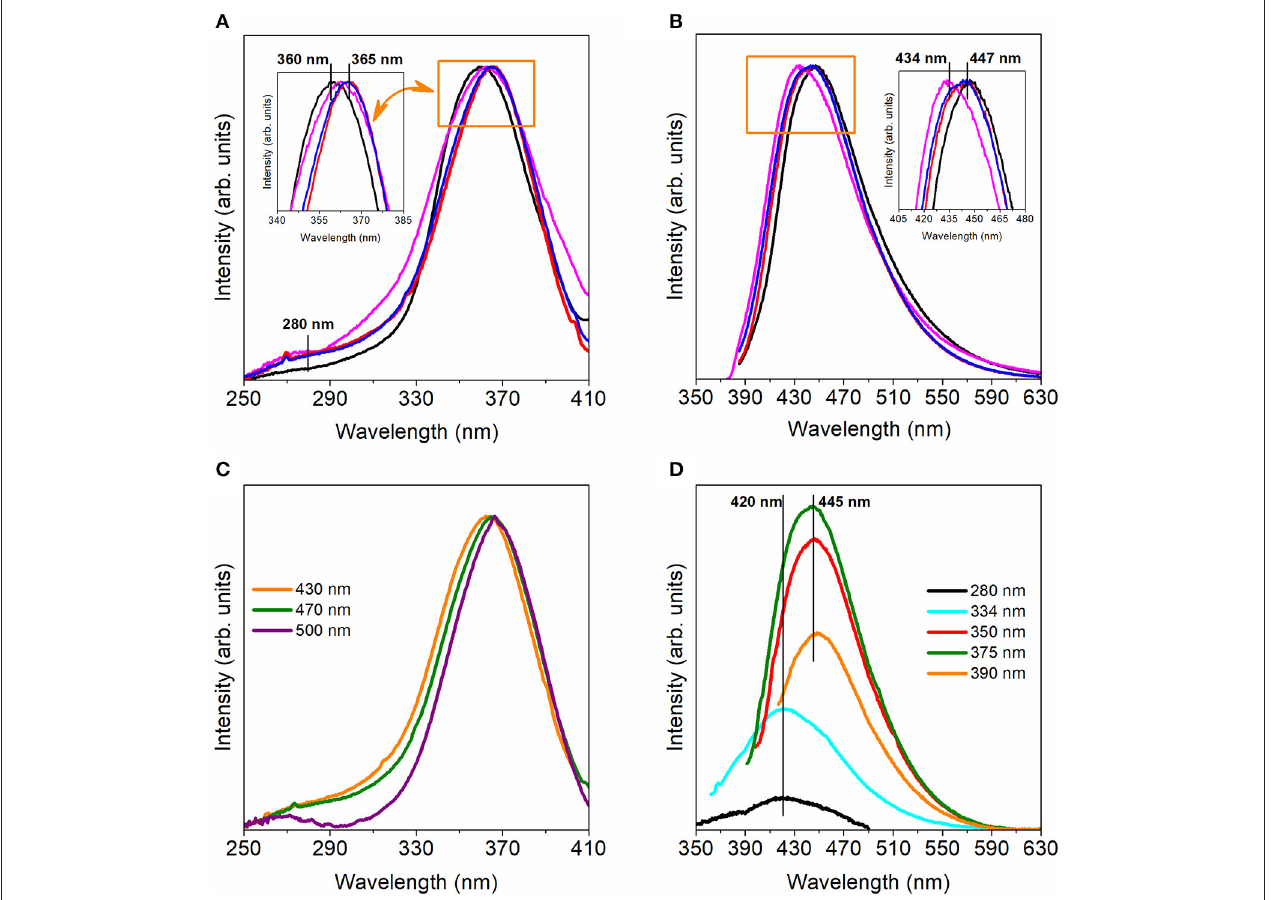
FIGURE 9 | Excitation (A) and emission (B) spectra monitored around 445nm and excited at 360nm, respectively, of the BS-1 (black line), BS-2 (magenta line), BS-3 (red line), and BS-4 (blue line) hybrids. Excitation (C) and emission (D) spectra of BS-4 monitored and excited at distinct wavelengths.